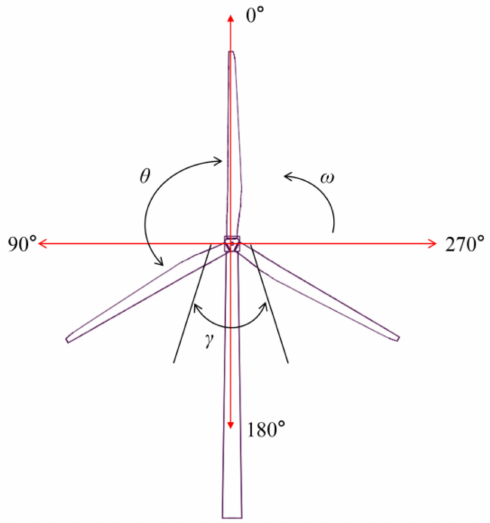
Figure 6. Schematic diagram of wind turbine blade-rotation phase